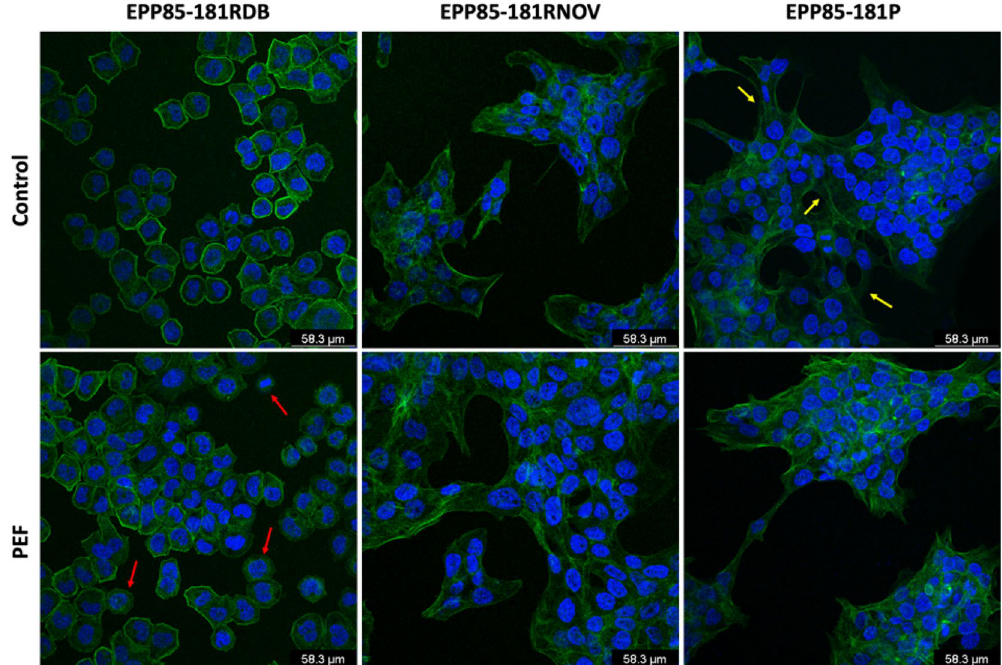
Figure 2. Fluorescent staining of F-actin (green) and nuclei (blue), red arrows show the loss of peripheral cytoskeleton in EPP85-181RDB cells after PEF stimulation, yellow arrows point the presence of protruding extremities before stimulation of EPP85-181P cells with PEF; nuclei (blue). Confocal microscope. Scale bar: 58.3